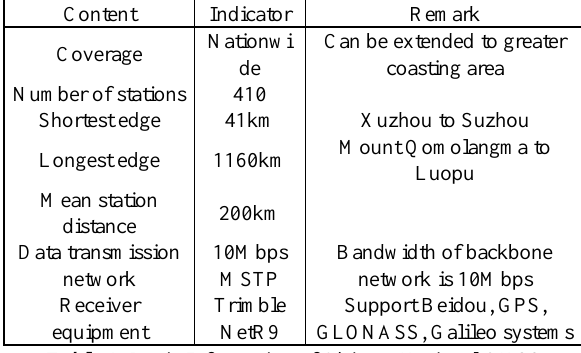
Table 1 . Basic Information of Chinese National GNSS